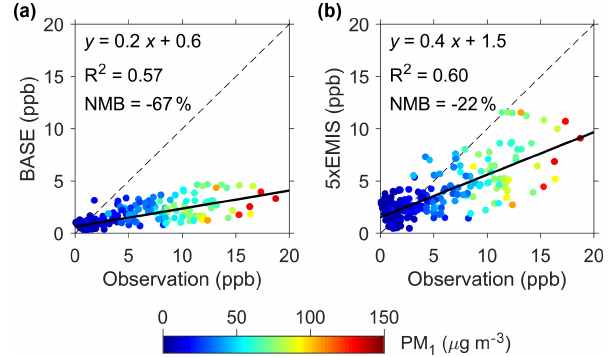
Figure 4. Comparison of modeled and observed HCHO concentra- tions. (a) BASE scenario. (b) 5 × EMIS scenario. The dots are col- ored according to PM 1 concentrations. Model results from WRF- Chem are